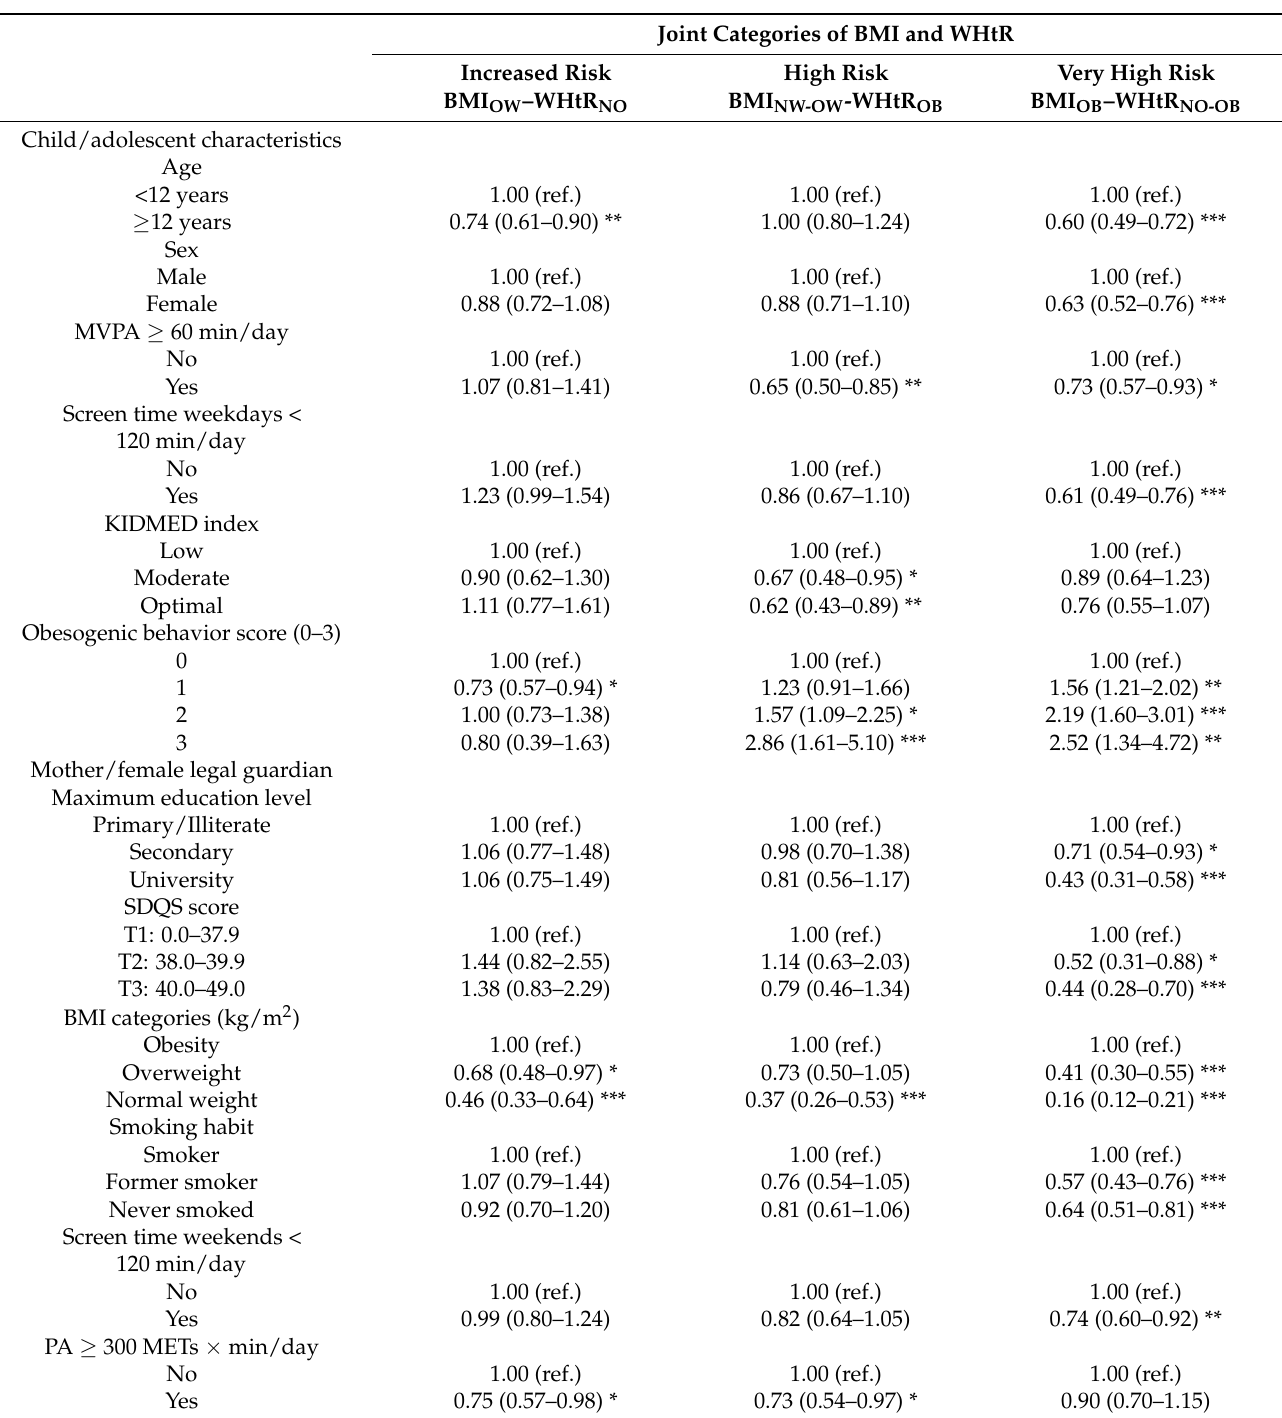
Table 3. Odds ratios (and 95% confidence intervals) from logistic regression showing the correlation of characteristics of child/adolescent and their mothers/female caregivers with children’s categories of BMI and